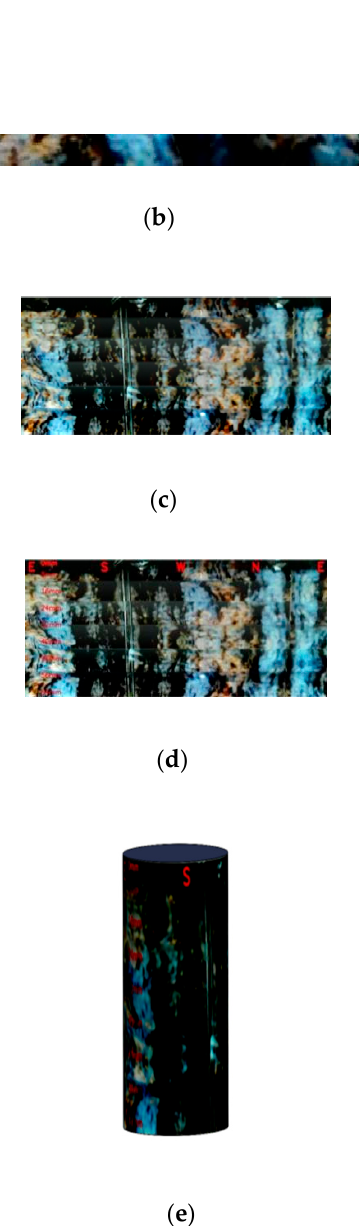
Figure 3. ( a ) Image of a fixed focus segment (in green circle) was captured from the elevation view, ( b ) corresponding distortion correction diagram in the focal segment, and ( c , d ) splicing using the coordinate value, and ( e ) corresponding three-dimensional visualization.